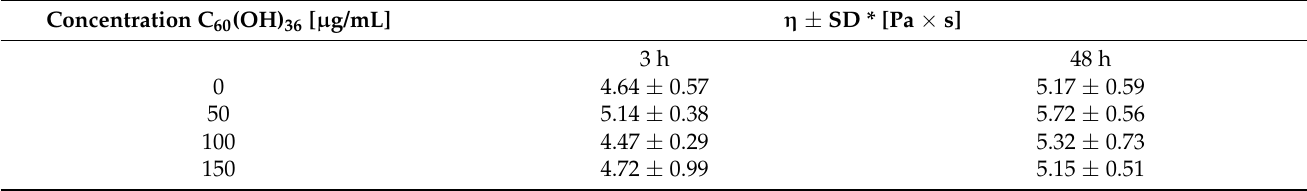
Table 4. Values of η determined using Tempamine in a suspension of erythrocytes incubated with C 60 (OH) 36 in the concentration range of 0–150 µ g/mL for 3 and 48 h at 37 ◦